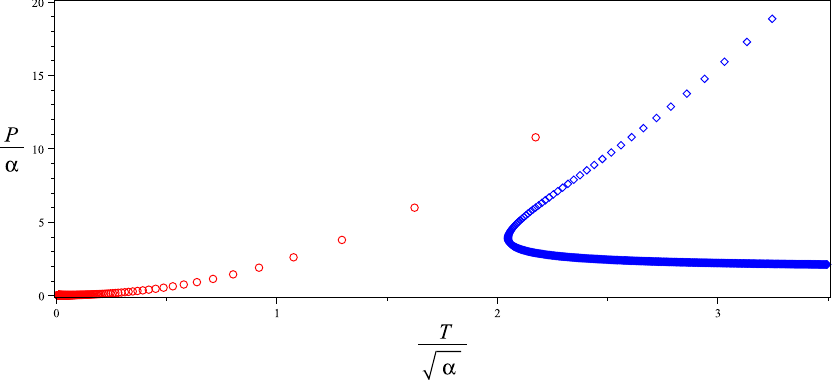
Figure 18 . Trajectory of both critical points, parametrized by (cid:22) Q . Red points, at the left, correspond to RN-AdS-like critical point and blue ones, at the right, to the hairy critical points. The zone where the points are more concentrated corresponds to the limit (cid:22) Q ! 1 , while the more diluted zone corresponds to the limit (cid:22) Q !